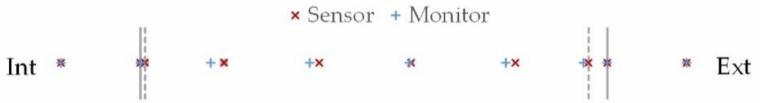
Figure 6. Sensors and monitors positions.